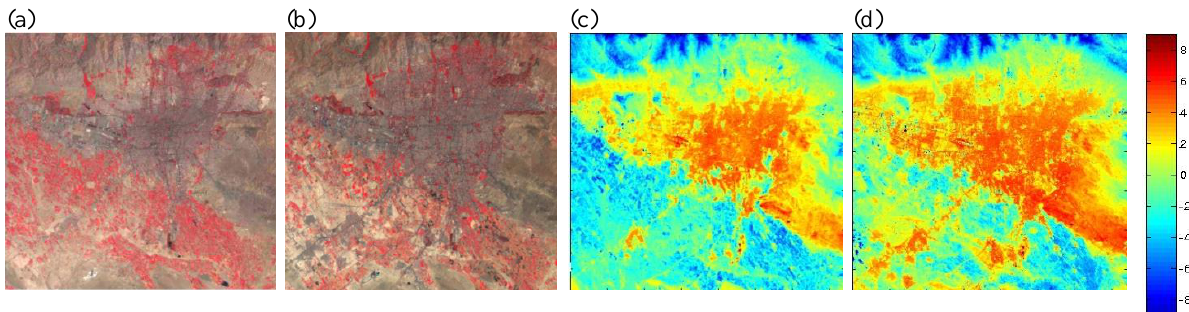
Figure 2. (a) False color combination of Landsat bands (4-3-2) in TM 1984, (b) ETM+ 2007, derived from nighttime Landsat images in (c) 1984 and (d) 2007.